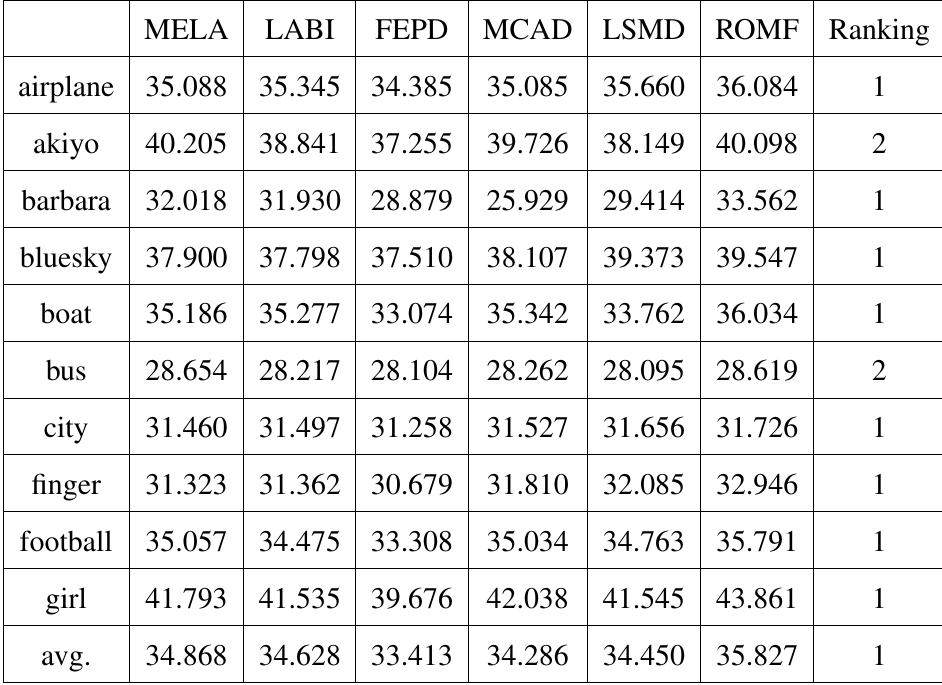
Table 2. Comparison of the average PSNR for 10 test images and video sequences among different deinterlacing methods.